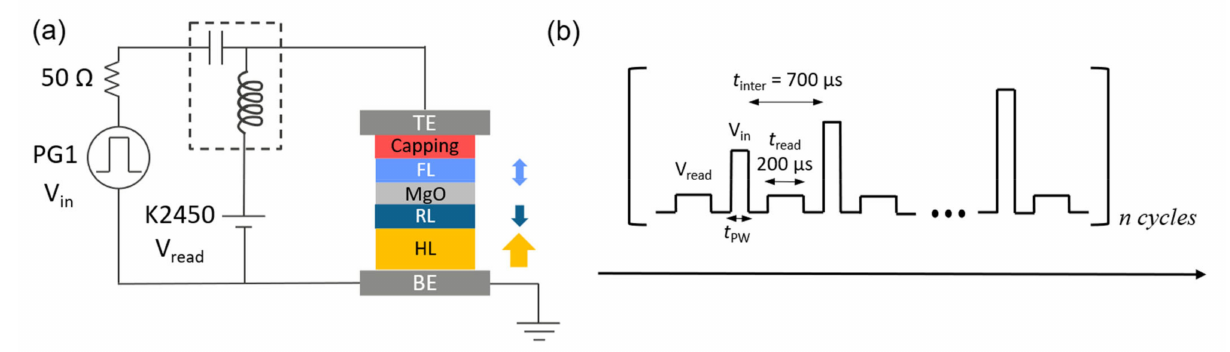
Figure 2. ( a ) Electrical measurement scheme for dc and pulsed measurements. A Keithley K2450 and Keysight M8190A pulse generator are connected through a bias tee (up to 6 GHz) to enable fast switching and DC readout of the resistance states; ( b ) waveform sequence for read and write pulses. The interval time between the pulses ( t inter ) and integration time of the read pulse ( t read ) have been optimized to ensure accurate